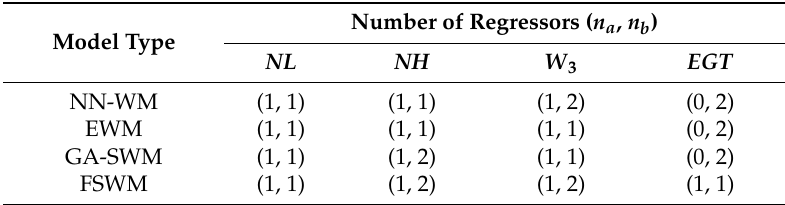
Table 4. Specifications of the optimal structure for Wiener